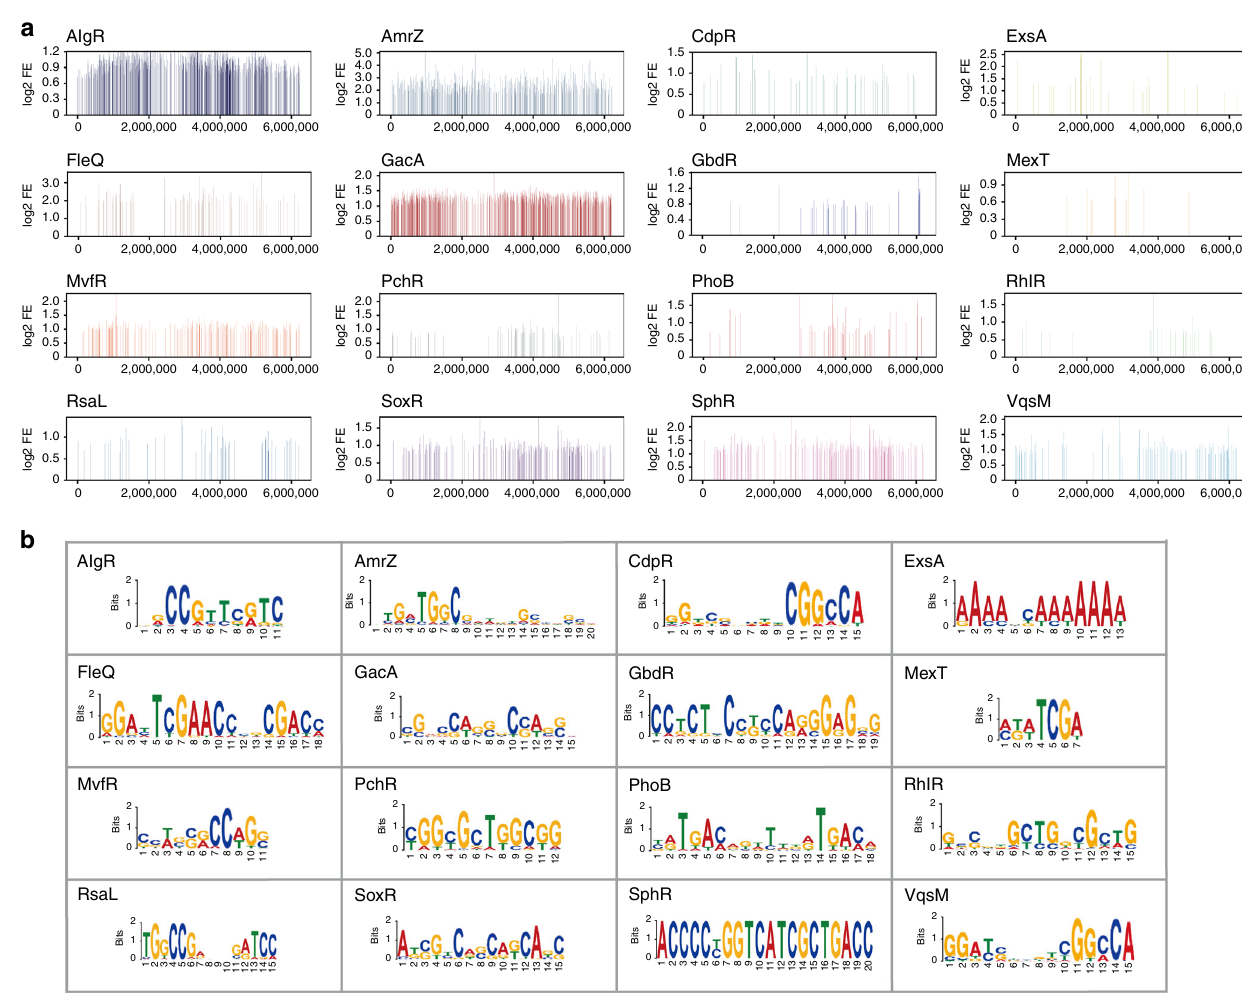
Fig. 2 Genomic location and binding motif analysis of 20 TFs. a The coverage of 16 transcription factors peak regions over Pseudomonas aeruginosa chromosome. Each line shows the location and signal enrichment value (log2 Fold Enrichment) of peaks of a transcription factor peak in chromosome. b The binding motifs of transcriptional factors were elucidated using MEME. All peaks were used to de fi ne the binding motif. The height of each letter presents the relative frequency of each base at different positions in the consensus